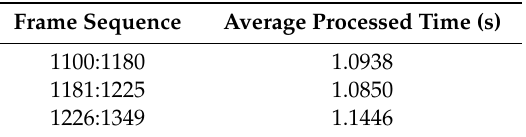
Table 1. Average execution time of registration and fusion algorithm over three representative frame